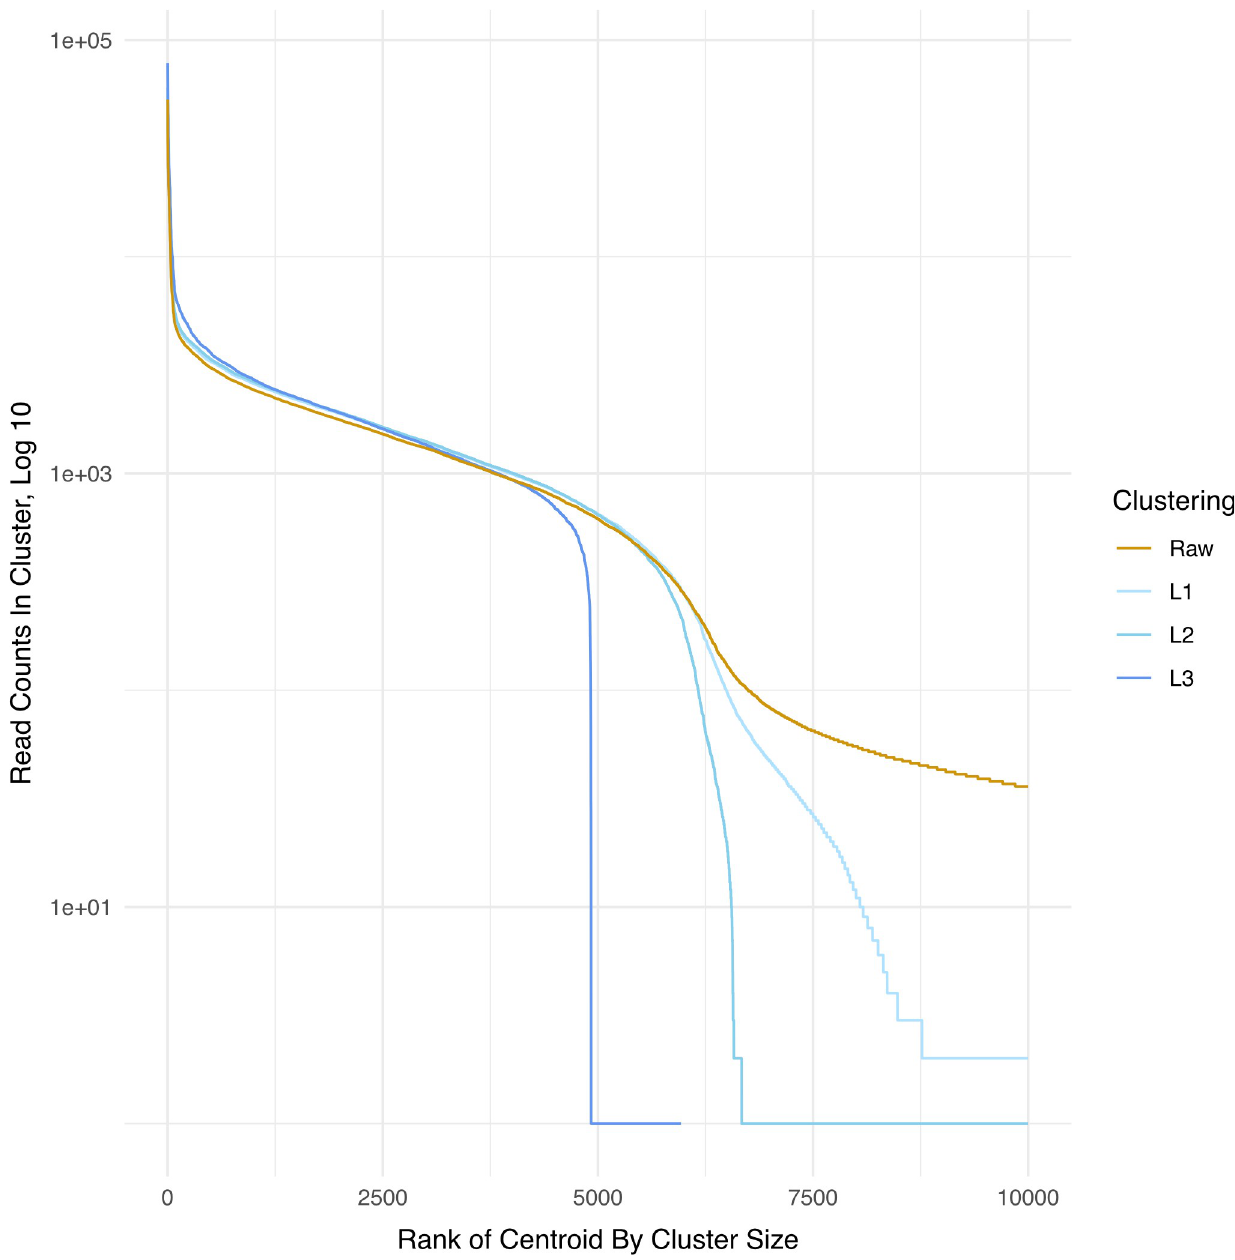
Fig 5. Comparison of barcode counts between raw and different clustering distances. This figure shows that the number of barcodes that are called decreases with the increasing clustering distance; clustering with L = 3 substantially decreases the barcode counts called in the raw sequencing reads. Note that the highest-count cluster is ranked 1. The figure is cut off to include only the 10,000 most abundant barcodes to focus on the “elbow” where the number of barcodes that are called display a steep